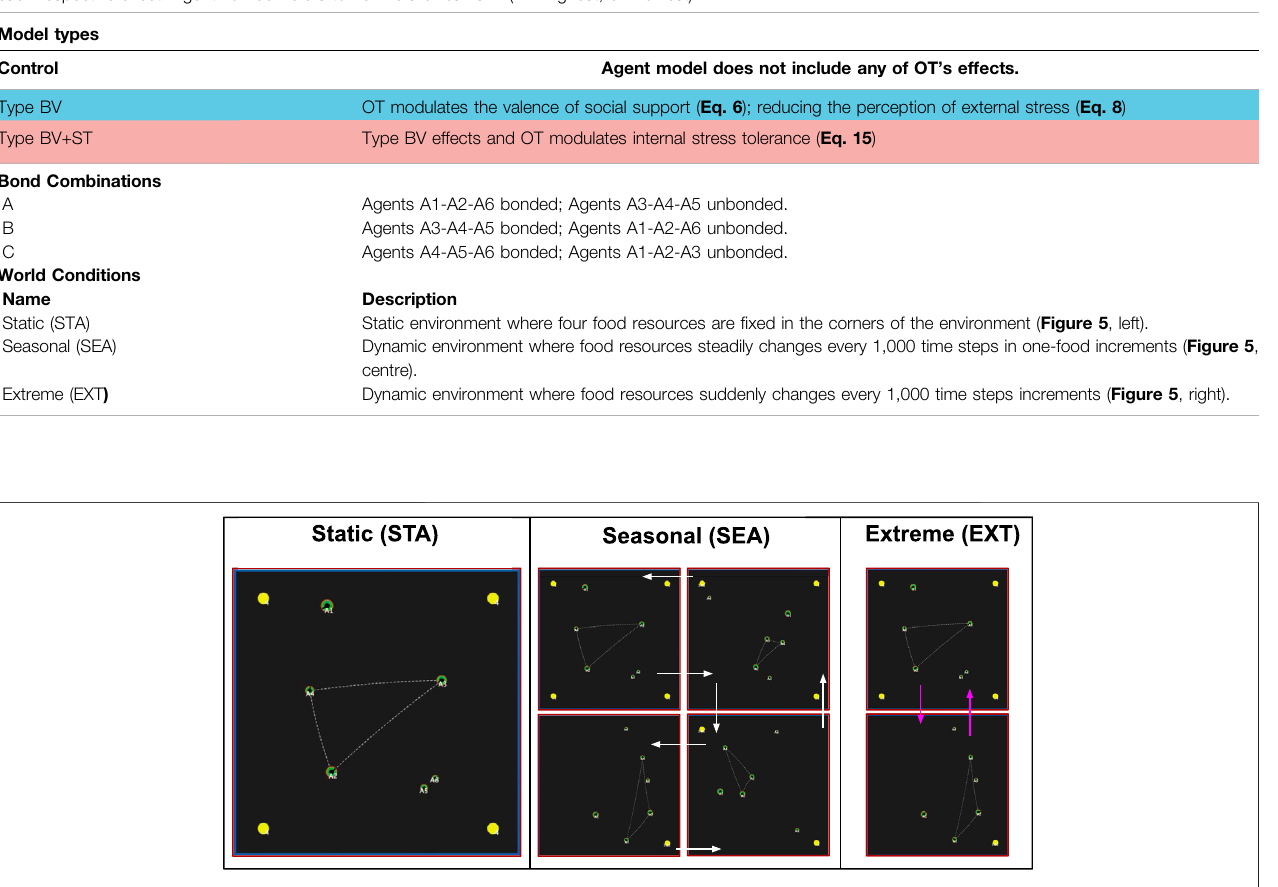
Frontiers in Robotics and AI |